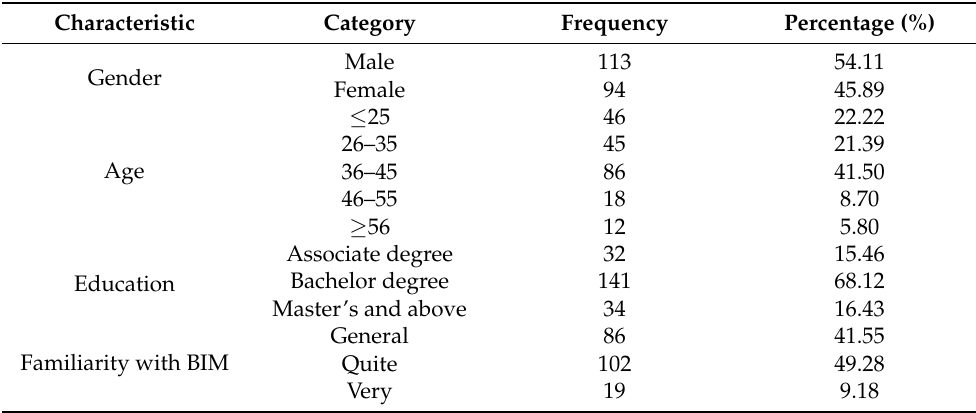
Table 2. Profiles of the